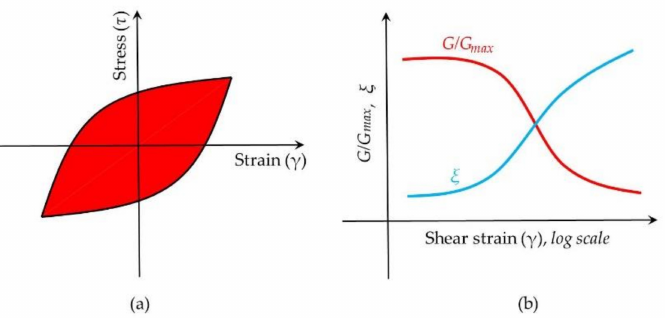
Figure 3. Hysteresis curve ( a ), shear modulus degradation curves G/G max ( γ ), and damping ratio curves ξ ( γ ) ( b ) models for cyclic